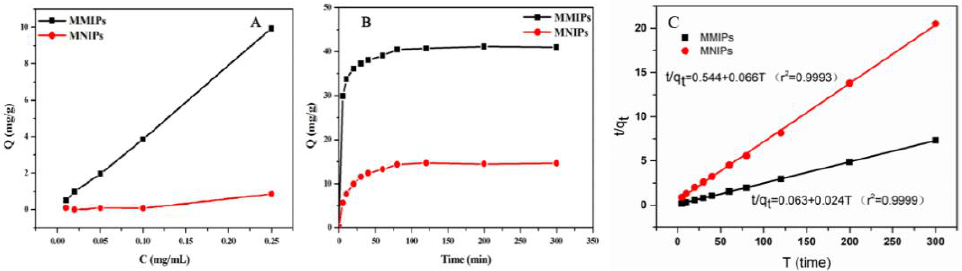
Figure 2. ( A ) Static adsorption curves of MMIPs and MNIPs; ( B ) dynamic adsorption curves of MMIPs and MNIPs; ( C ) dynamic adsorption curves fitted by the pseudo-second-order model. Four parts of 20 mg MMIPs powder and four parts of 20 mg MNIPs powder were